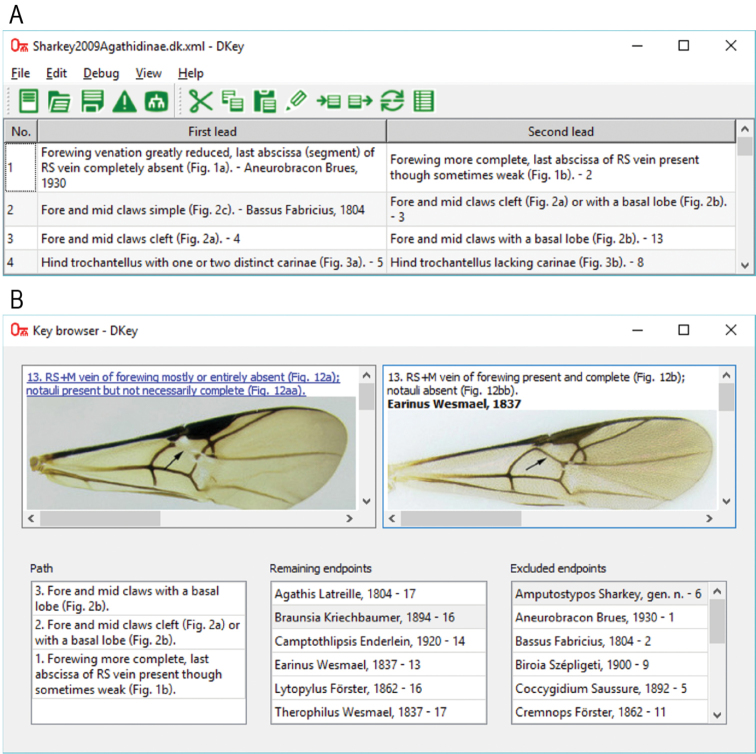
An example of using the DKey software based on the key to the genera of Agathidinae (Sharkey et al. 2009). The key was imported to the DKey software (A) and displayed in an interactive key browser (B).